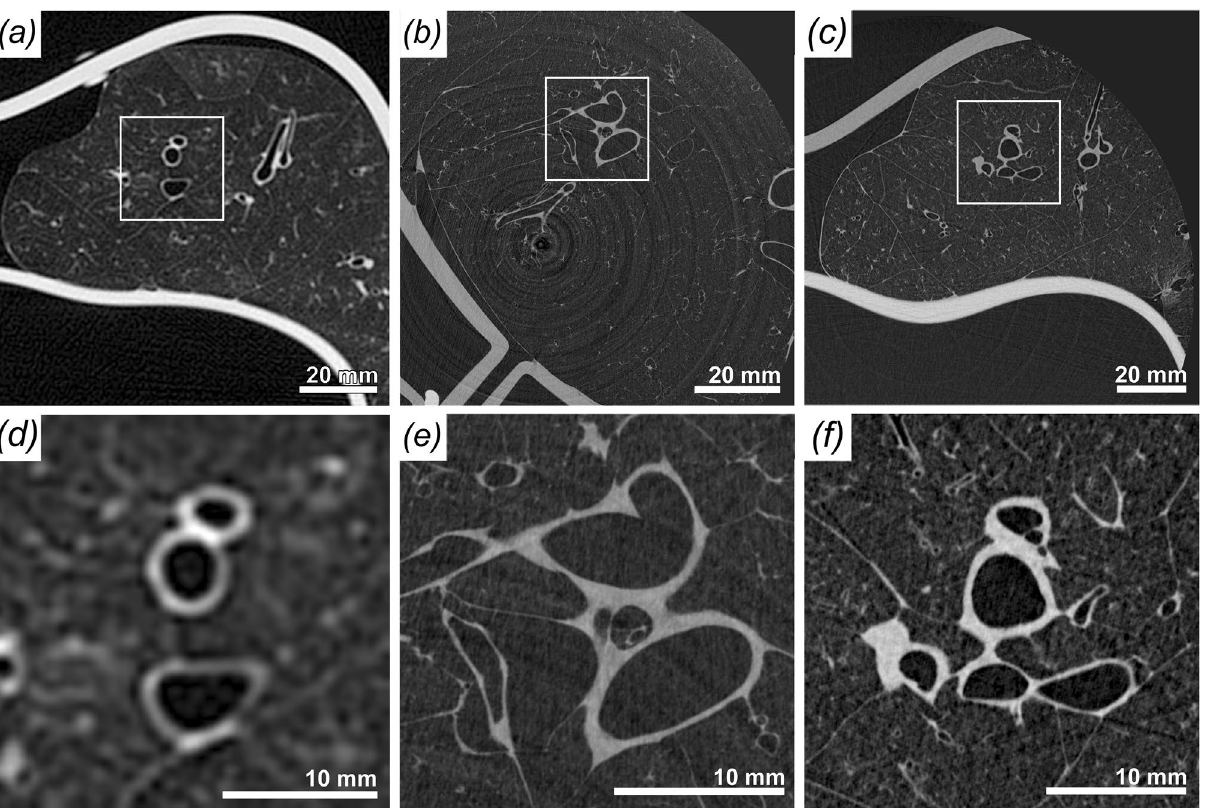
Figure 3. Comparison of the different imaging setups based on scans of three different healthy pig lungs. ( a ) High resolution clinical CT, effective pixel size 455 µ m , entrance dose 13 mGy. ( b ) SyRMeP synchrotron setup, SDD 2.7 m, effective pixel size 89 µ m , entrance dose 10 mGy. ( c ) SyRMeP synchrotron setup, SDD 10.7 m, effective pixel size 67 µ m , entrance dose 10 mGy. ( d ), ( e ), ( f ) show zoomed in parts of the images above.